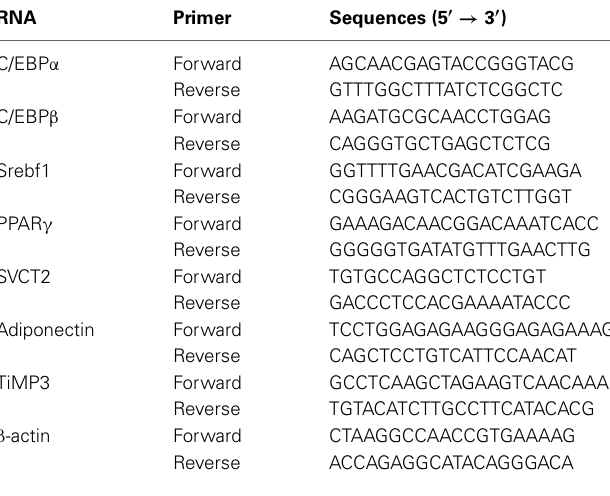
Table 1 | Specific primers used in qPCR experiments.